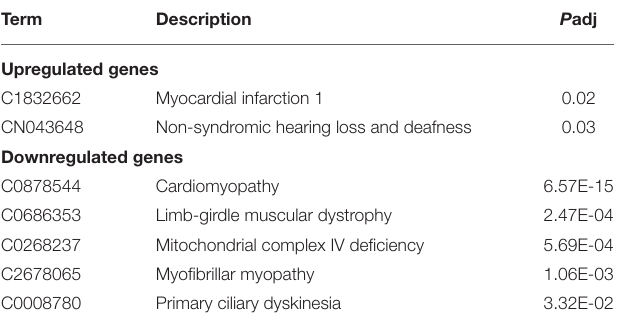
TABLE 3 | ClinVar human diseases analysis of DEGs.